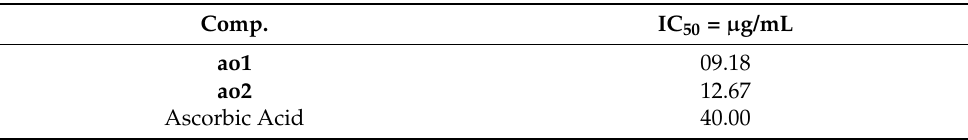
Table 54. In vitro antioxidant activity of the synthesized compounds ( ao1 – ao2 ) using the DPPH scavenging